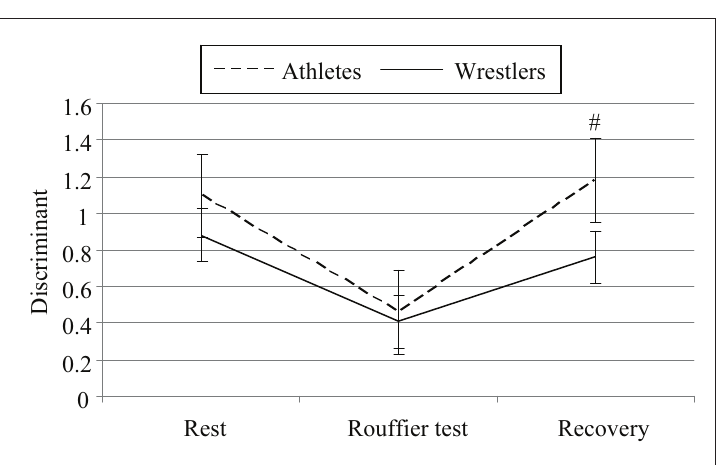
Figure 3. Dynamics of QRS complex and JT interval interaction (subsystemic level– regulatory processes) during dosed exercise